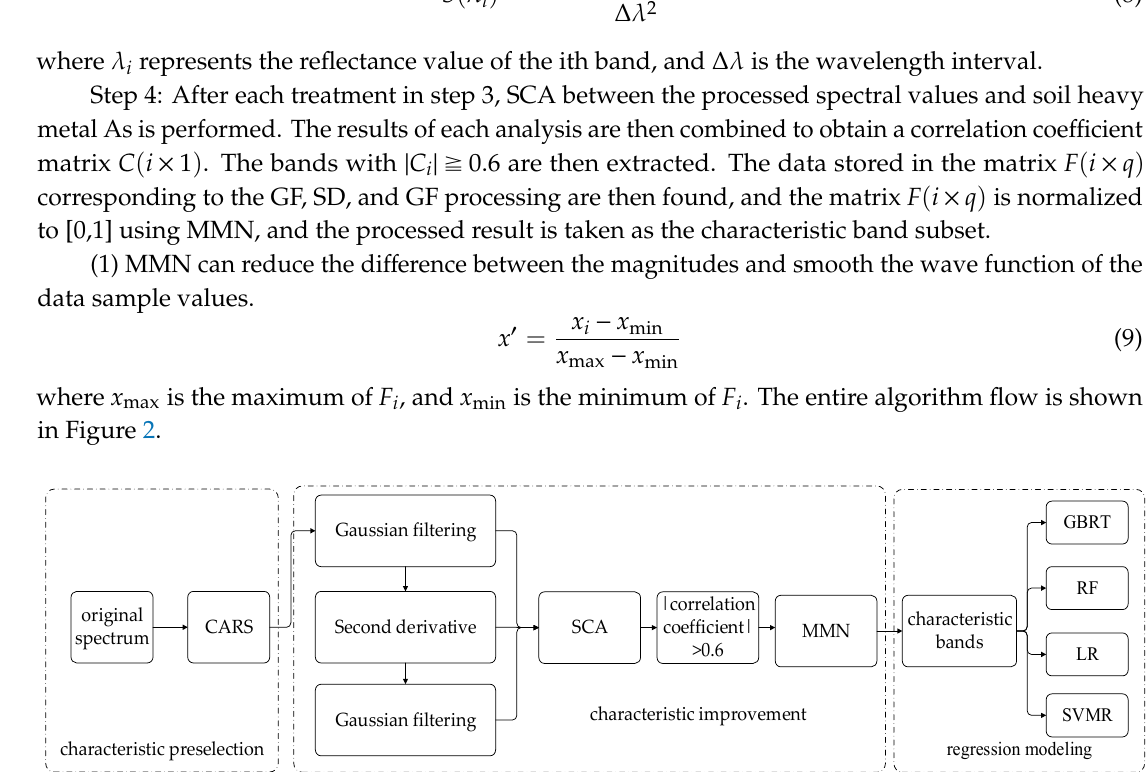
Figure 2. Characteristic band selection algorithm flowchart.